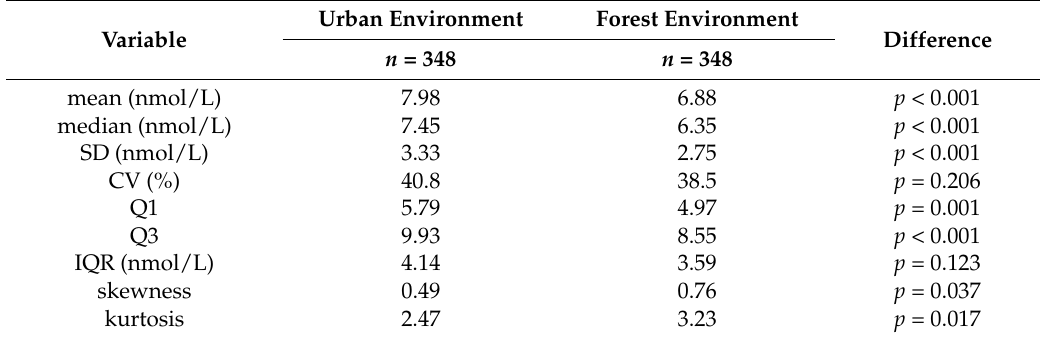
Table 2. Distribution characteristics of salivary cortisol measurements in urban and forest environments. Variable